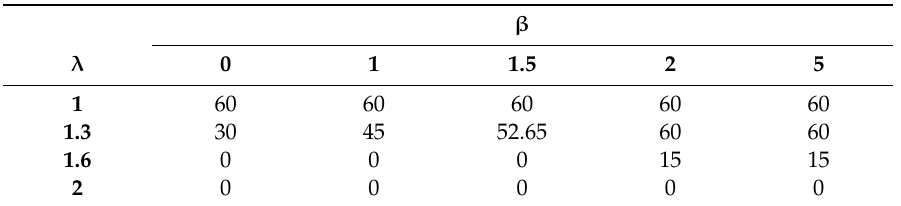
Table 6. Weekly forward contract unit price ( € / MWh).